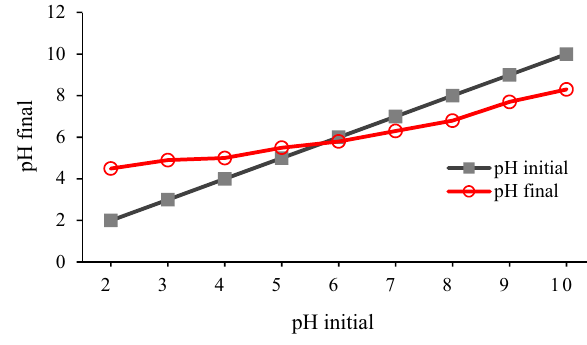
Figure 4. The pH pzc of ZF-NPS.